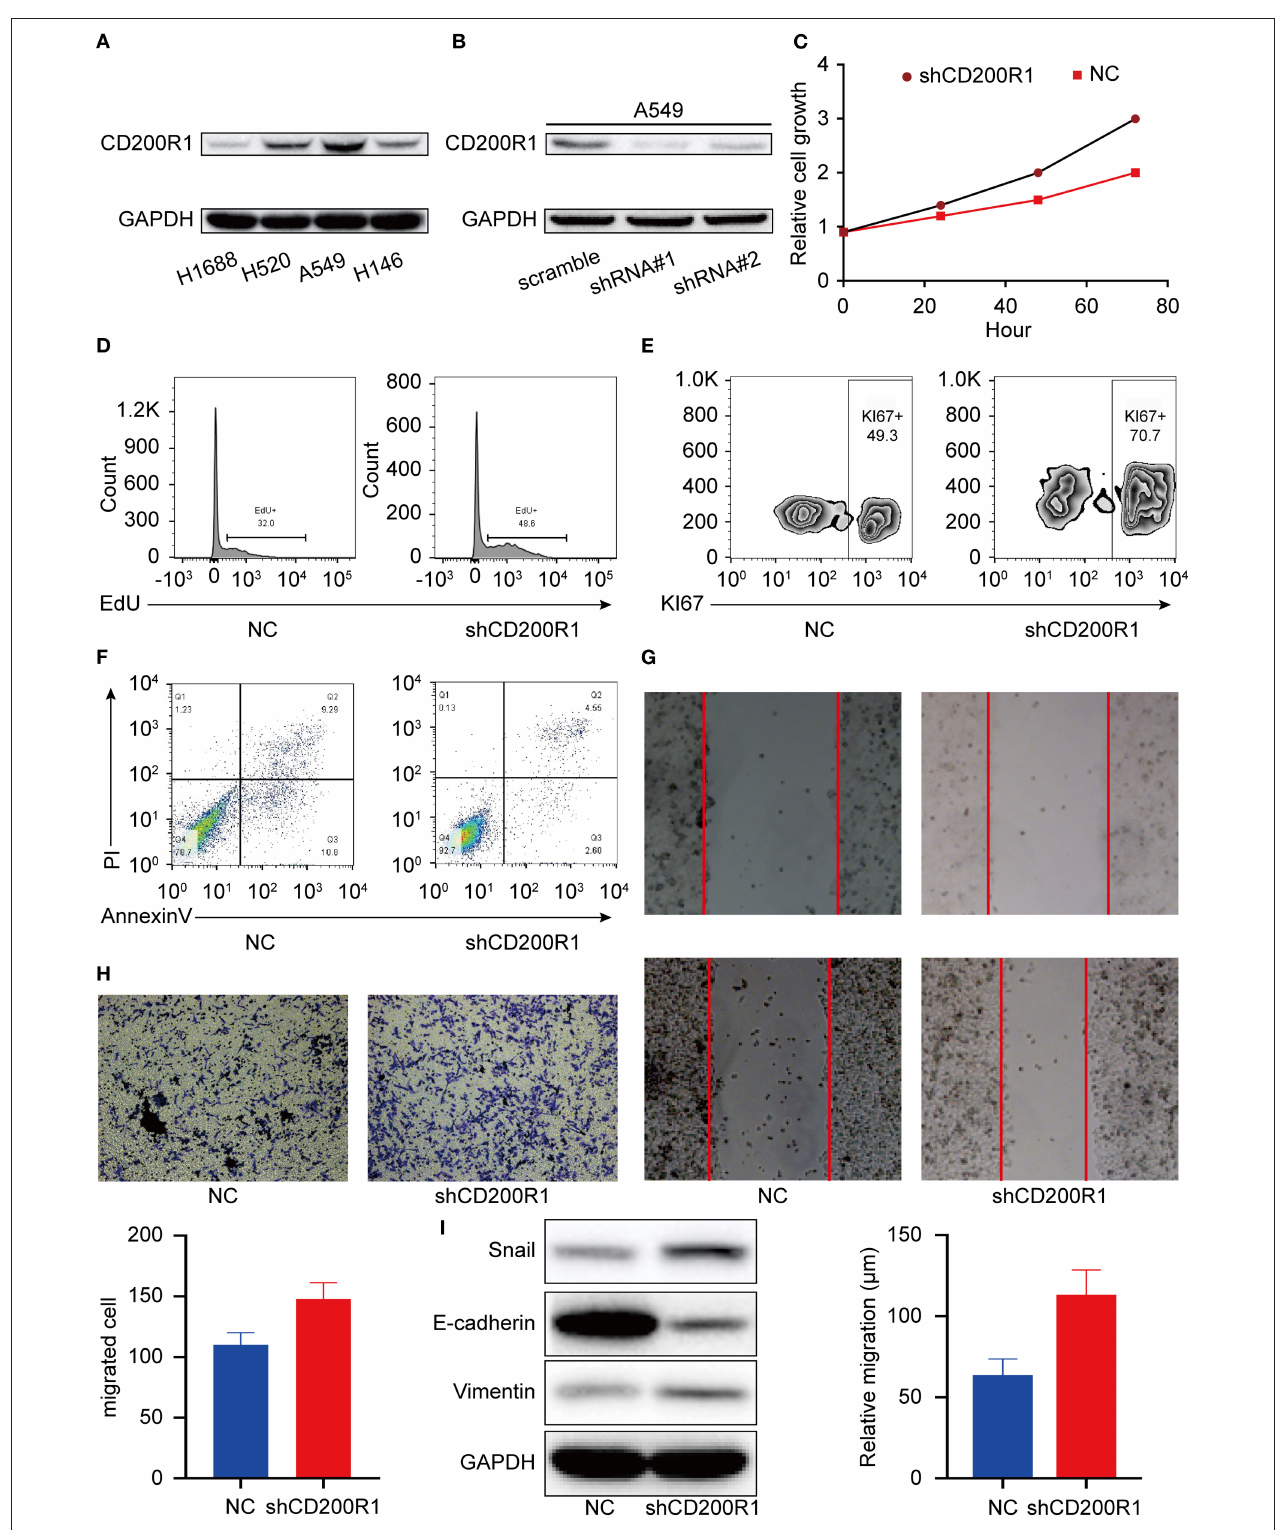
FIGURE 10 | Biological behavior of CD200R1 in lung adenocarcinoma. (A) Baseline expression of CD200R1 in four kinds of cancer cells; (B) Two shRNA targeting CD200R1 was transfected into A549, effect of knock down was confirmed by western blot; (C) Cancer cell growth rate was increased after CD200R1 was knocked down; (D) S phase distribution was increased after CD200R1 was down-regulated. (E) Percentage of Ki67 positive was used to confirm the effect of CD200R1 on cell proliferation. (F) Apoptosis rate was studied by ANNEXINV stain; (G,H) The effect of CD200R1 on cell migration was studied by transwell and wound healing assay; (I) The expression of Snail and Vimentin was increased and that of E-cadherin was reduced, indicted EMT was occur after CD200R1 was knocked down.